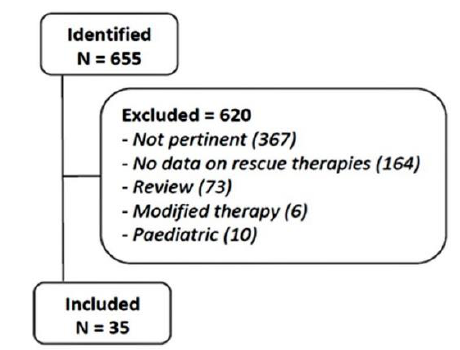
Figure 1. The flow chart of the literature review.